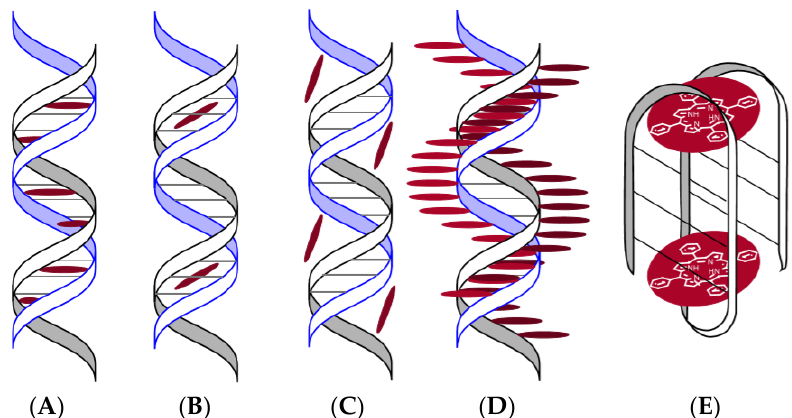
Figure 10. Schemes of complexes of P&A with DNA ( a – d ) and with G-quadruplexes ( e ) [64]. Internal complex ( a ), binding to a small groove of DNA ( b ), binding to a large groove of DNA ( c ), external binding with self-stacking along the DNA surface ( d ), and binding to a G-quadruplex ( e ).